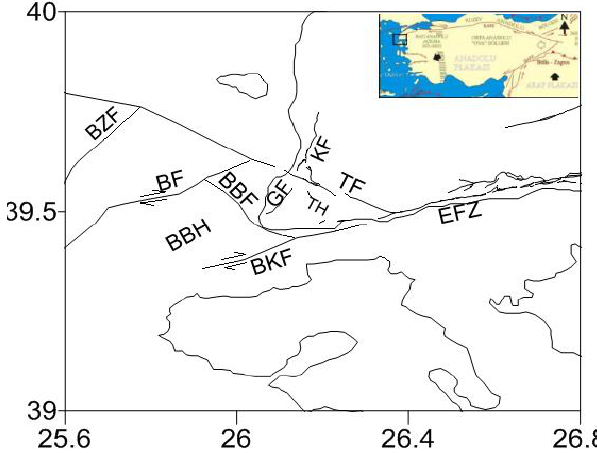
Figure 1. The active fault map of the vicinity of Canakkale- Ayvacik (MTA). TF, Tuzla Fault; BBF, Bababurnu Fault; BBH,